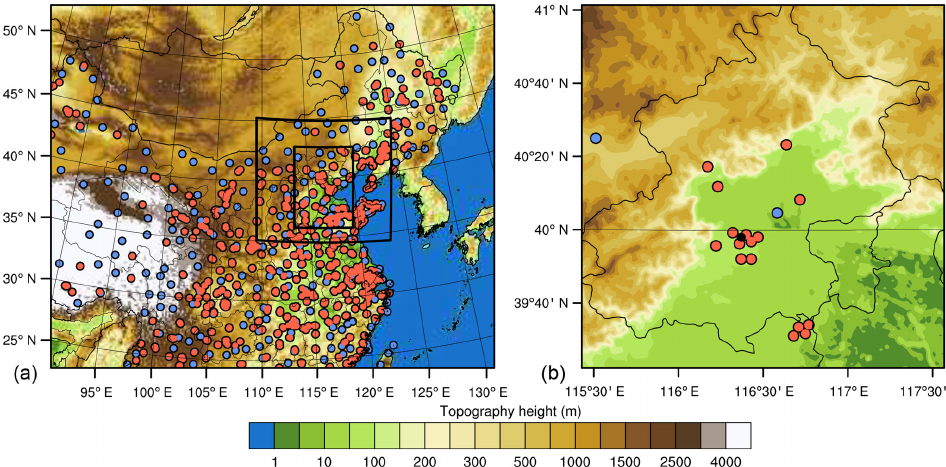
Figure 1. Map of the model domain (a) showing nests over northern China and the North China Plain, and map of Beijing municipality (b) showing the location of IAP (black) and measurement stations for meteorology (blue) and air quality (red). Table 1. Model configuration used in this